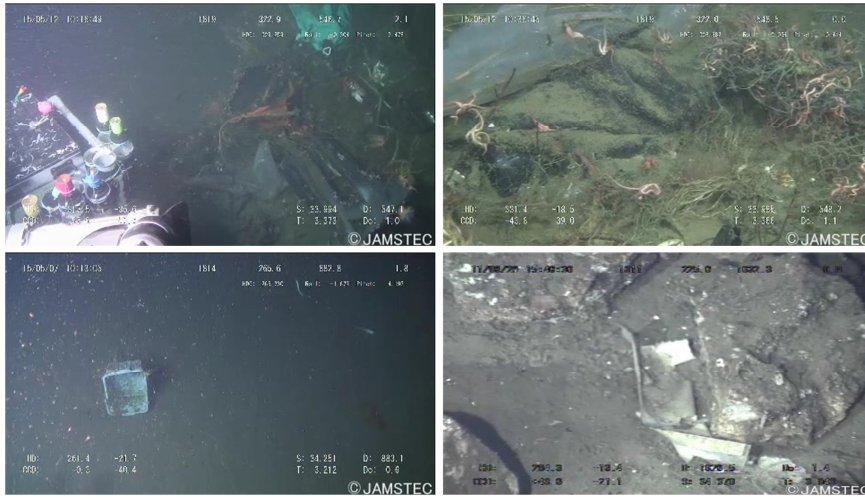
Figure 7. Display of some images in the Trashcan dataset.